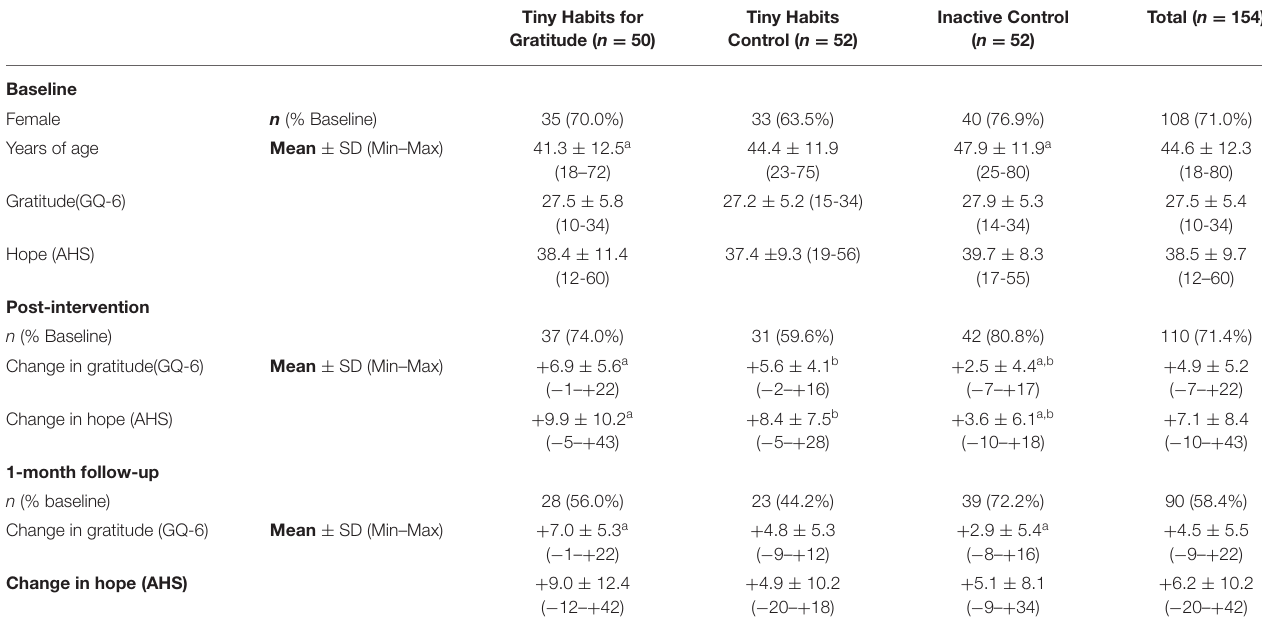
TABLE 2 | Demographics and outcomes data for participants.